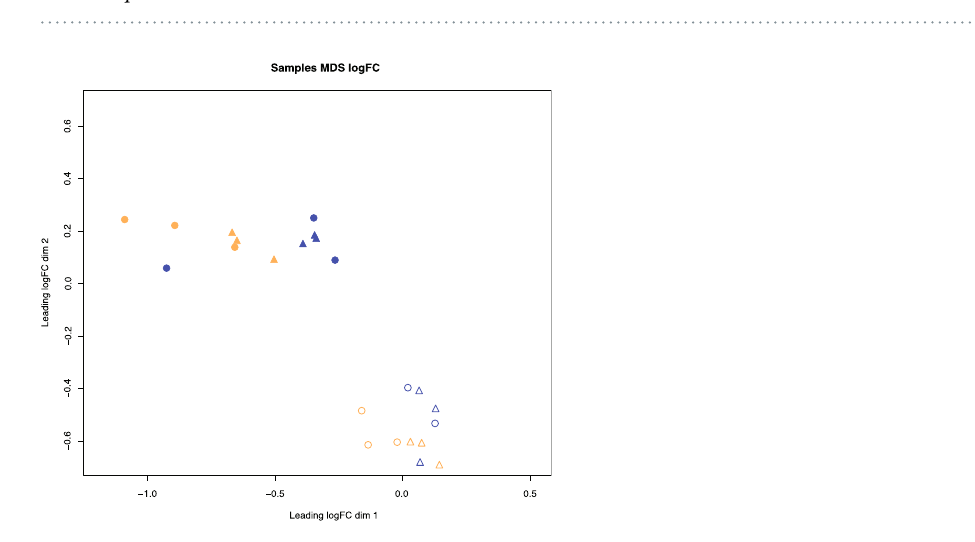
Figure 2. A dendrogram based on 194,469 SNPs showing the genotypic variation among the 35 samples of Rhinella spinulosa .